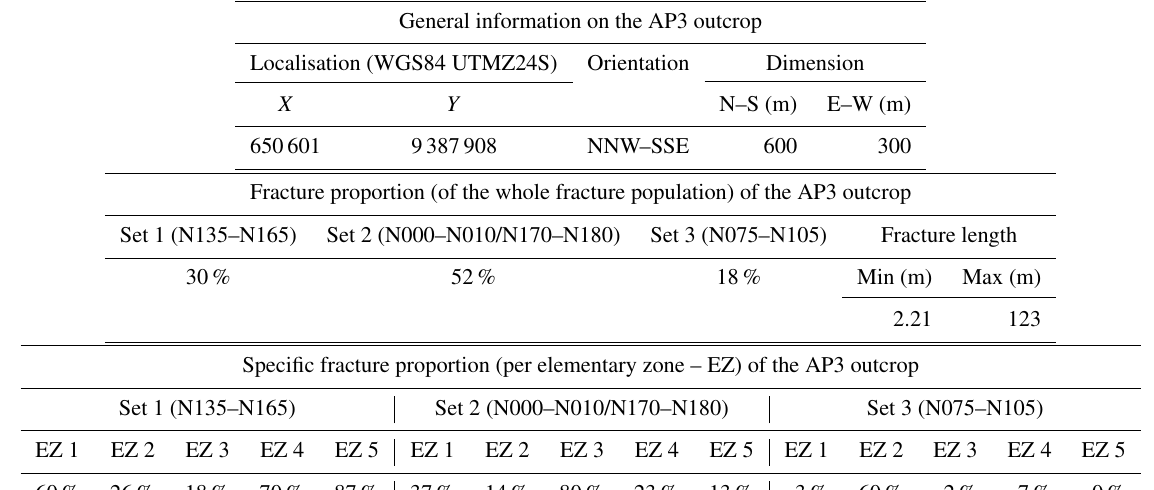
Table 1. Outcrop characteristics and fracture parameters collected from AP3 and